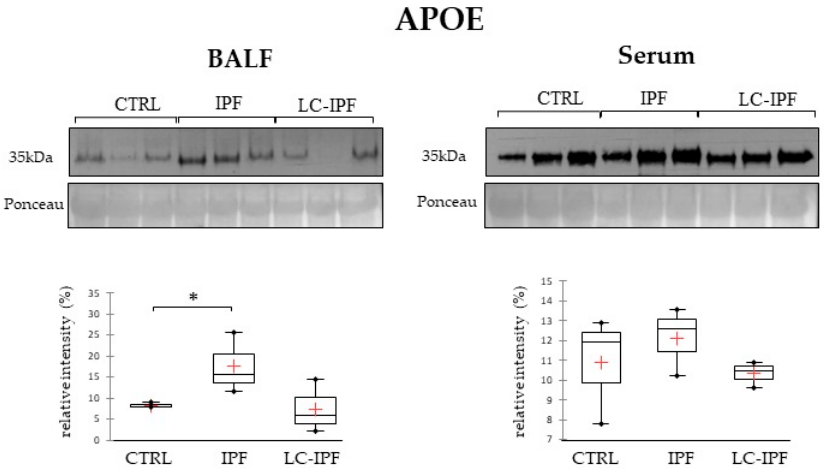
Figure 9. Western blot analysis of APOE in BALF and serum samples. Statistical analysis was performed by Kruskal–Wallis test and Dunn correction and reported in the box plots for CTRL–IPF– LC-IPF ( ∗ p -value < 0.05). Ponceau red is reported to assure the equal loaded amount of sample and for the intensity normalization. BALF and serum samples used for WB were three for CTRL, three for IPF, and three for LC-IPF.